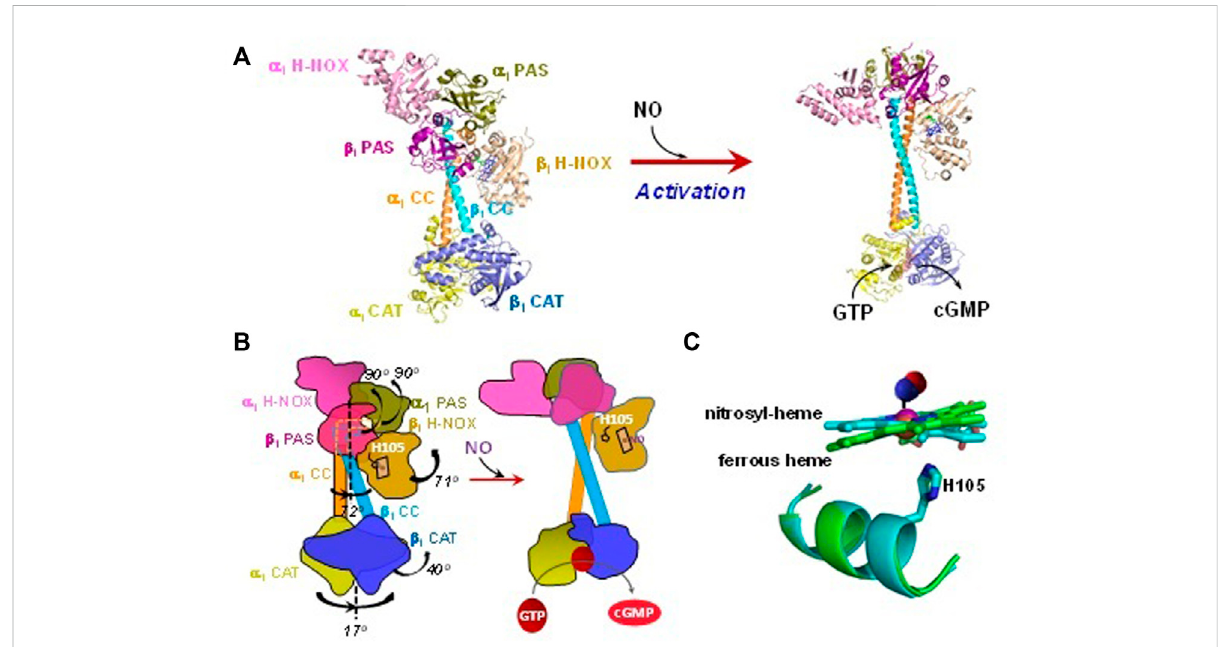
FIGURE 1 Structural changes of sGC in response to NO-dependent activation. (A) The structures in different states are plotted using PyMol: Unliganded ferrous state (PDB 6JT0) and NO-bound activated state (PDB 6JT2). (B) Cartoons to demonstrate structural rearrangement of the domains in sGC upon NO-activation. (C) Heme and the proximal ligand His105 are overlapped to show the conformational change in resting and NO bound states. The NO molecule, which is not visible in structure PDB 6JT2, is manually added in a random con fi